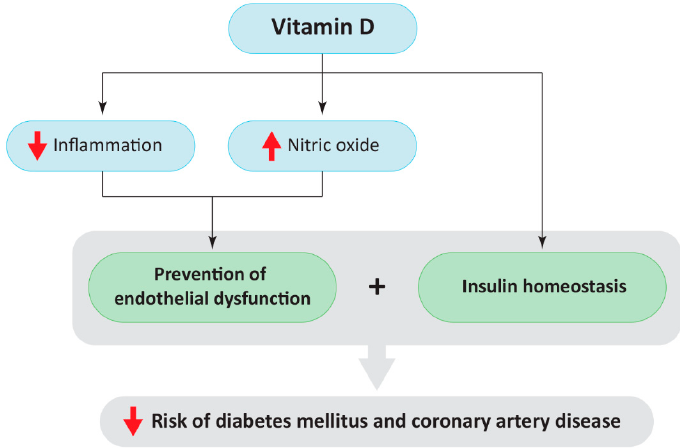
Figure 4. Summary of the positive effects of vitamin D on insulin homeostasis, inflammation control, and nitric oxide production to prevent endothelial dysfunction.